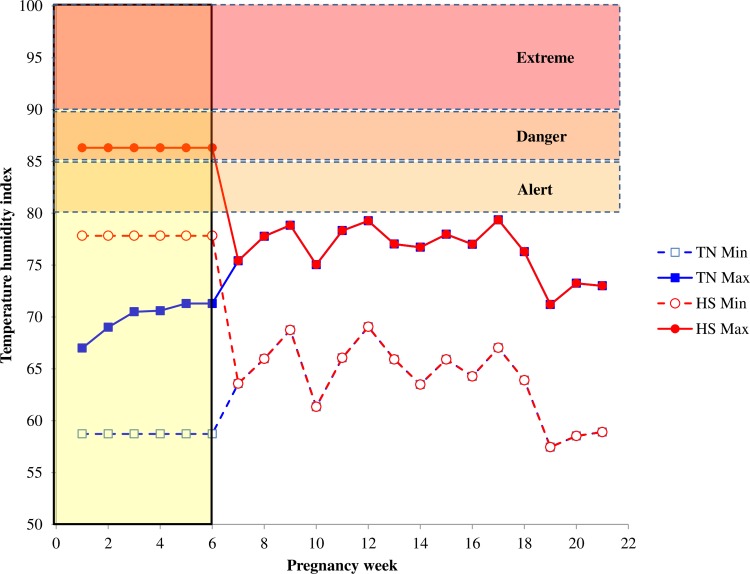
Minimum and maximum THI values throughout the experiment.The vertical shaded strip indicates when goats were in 2 climatic chambers under thermal-neutral (TN) and heat stress (HS) conditions. Afterwards, both goat groups were moved to the barn under semi-extensitve conditions. Levels of heat stress (alert, danger, and extreme) are indicated by the horizontal shaded strips according to Silanikove and Koluman [20]. For the first 6 weeks of pregnancy, HS-goats were in the danger level only during the day time and decended to the normal level during night. When goats were moved to the barn the maximum THI values were in the upper part of the normal level. The THI values were calculated using temperature and humidity data recorded by the data loger when goats were in the climatic chambers, and by the data provided by the closest meteorological ststion when they were in the barn.